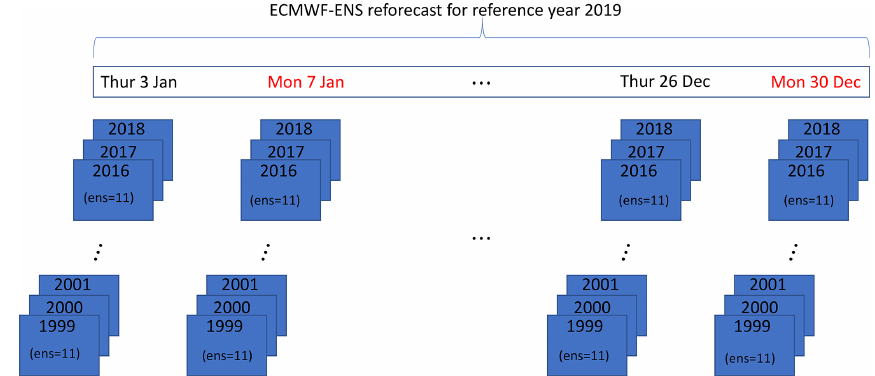
Figure 3. ECMWF-ENS reforecast schematic for the reference period January to December 2019 with 11 ensemble members (ens = 11).